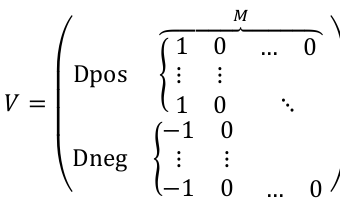
12 of 21 Figure 2. Illustration of Theorem 2. Blue plot corresponds to the Fourier transform of the signal 𝑈(𝜔) and red plot corresponds to the Fourier transform of the noise Ξ(𝜔) . ( a ) Original signal and noise; ( b